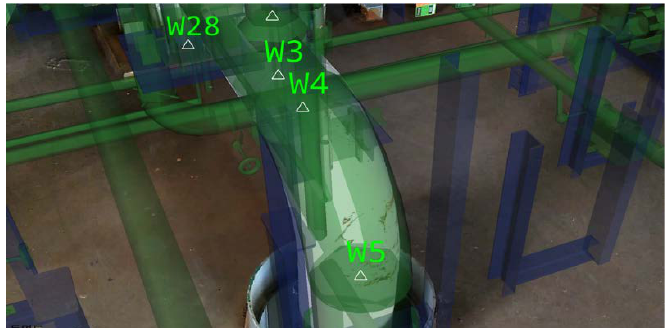
Figure 20. Intuitive viewing of engineering points with AR visualization.